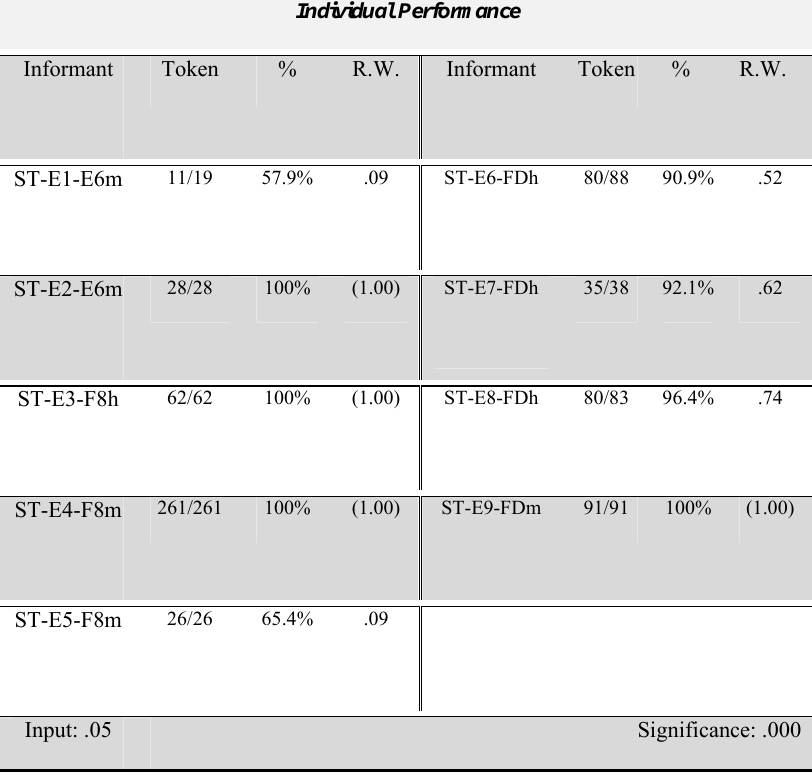
Table XVI. Actuation of individual performance for the presence of plural mark within the NP, based on a sample of speech of students from São Tomé Individual